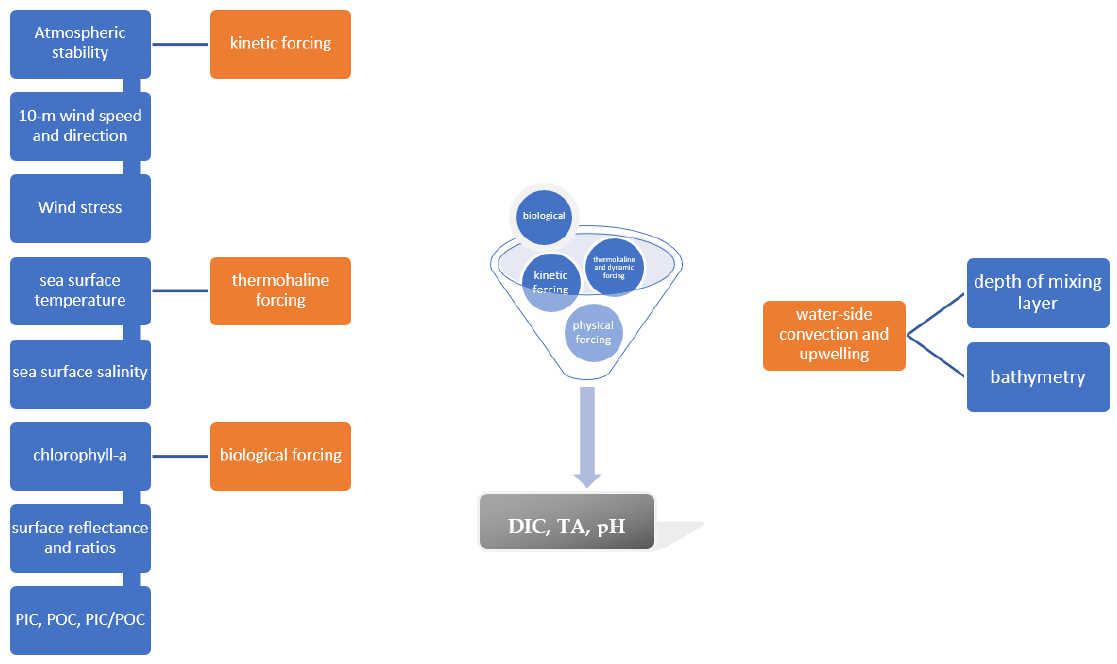
Figure 2. Linkage between the various groups of environmental drivers and how these were used to model or predict the three target parameters of surface DIC, TA, and pH. The environmental drivers can be seen as representing some of the main met-ocean processes influencing these three target variables (based on [38]).